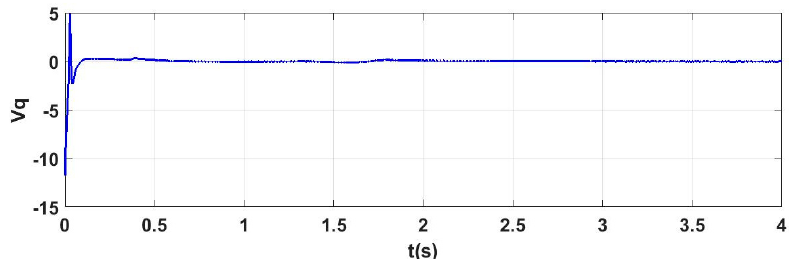
Figure 9. Voltage (cid:1874) (cid:3044) measured by PLL, affected by optimal levels for micro-grid and network